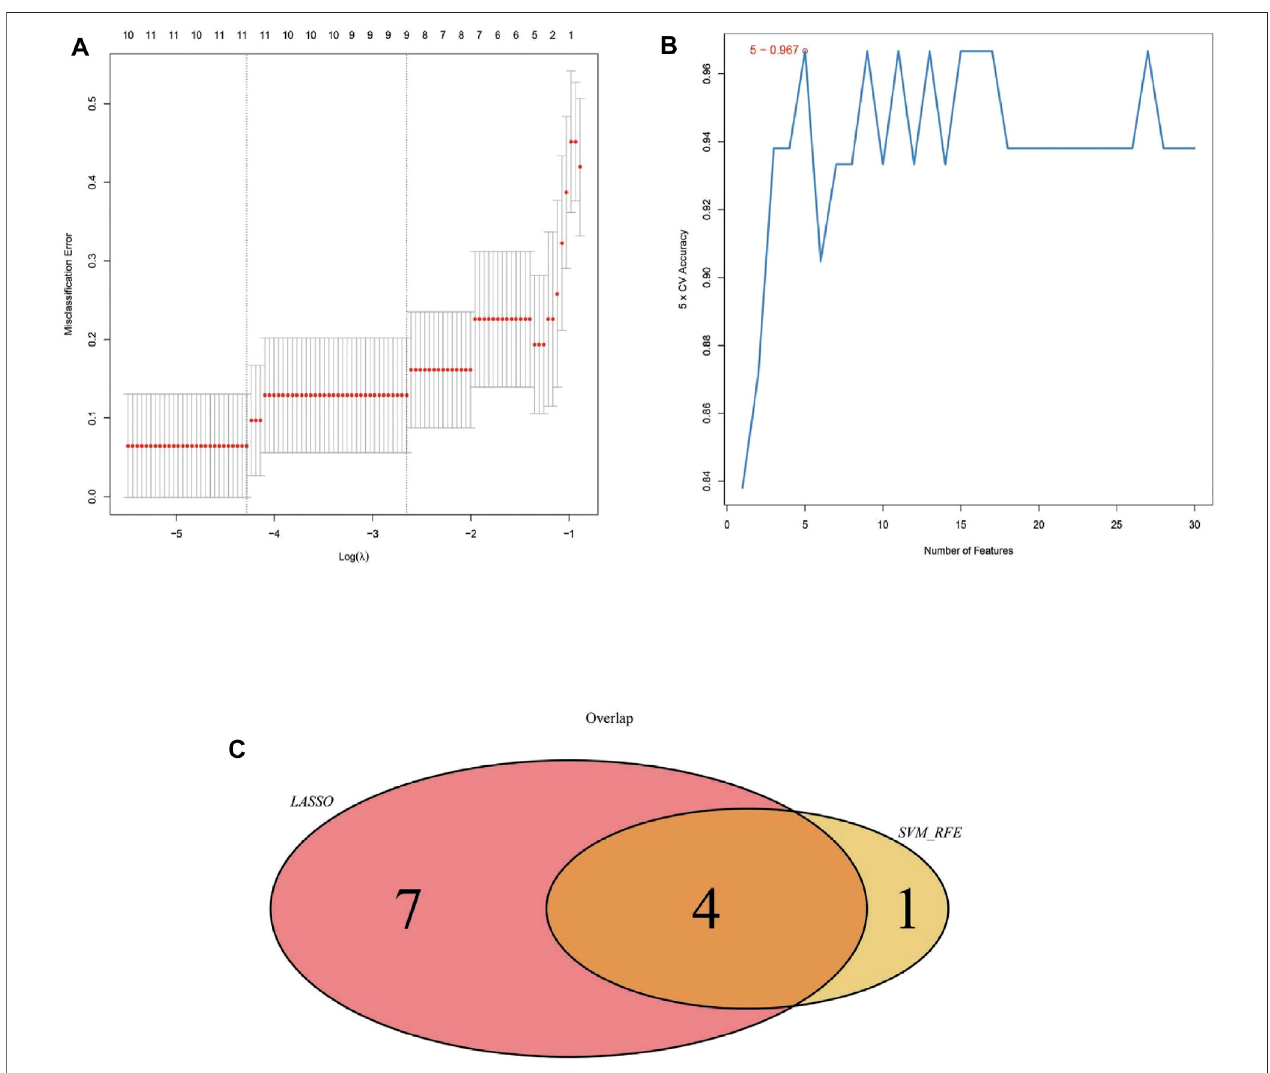
FIGURE 6 | Identi fi cation of key genes through LASSO and SVM analysis. (A) Cross-validation for tuning parameter selection in the LASSO regression model, dotted vertical lines were drawn at the optimal values, and 11 genes were screened. (B) SVM-RFE algorithm wasappliedto screened genes. The red dots indicated the number of genes achieving the highest accuracy. (C) The venn diagram showed the intersection of the genes that obtained from the LASSO and SVM-RFE algorithms.